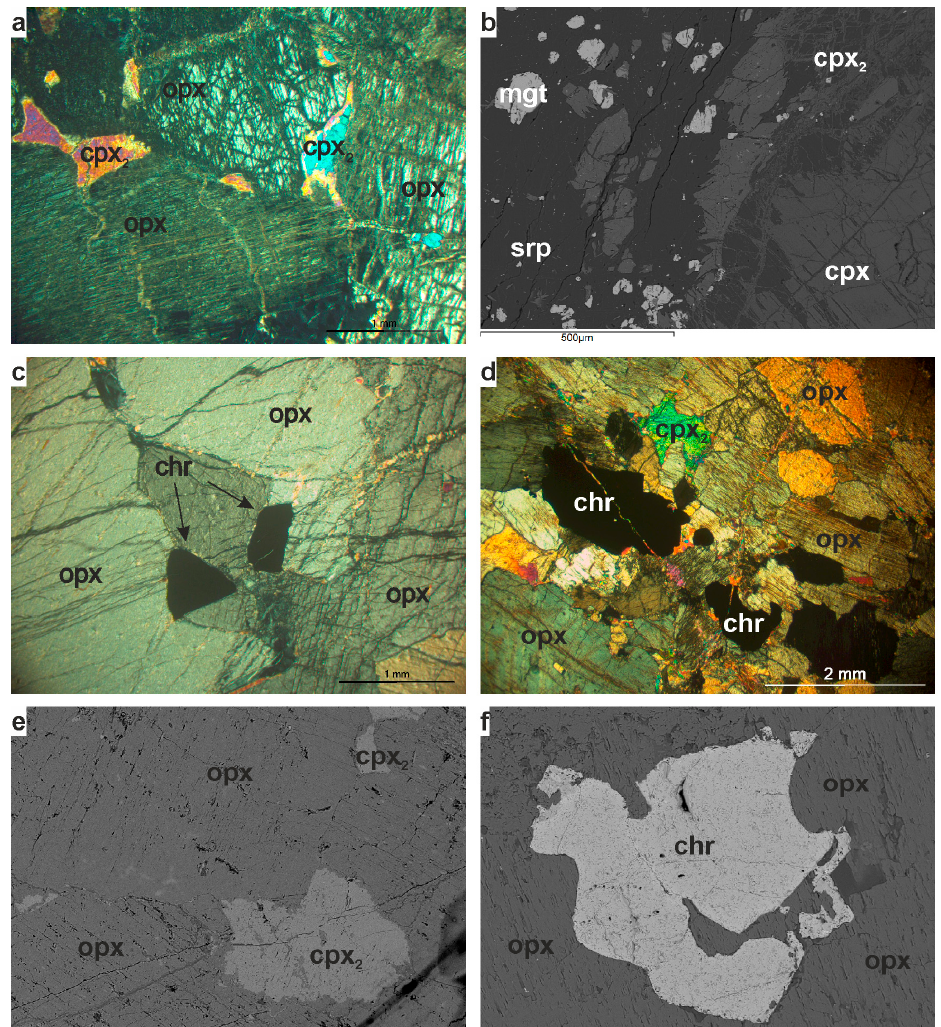
Figure 2. Textural characteristics of the pyroxenites from the Veria-Naousa ophiolite: ( a ) photomicrograph of porphyroclastic orthopyroxene (opx) with lesser clinopyroxene neoblasts (cpx 2 ) with irregular shapes in a websterite (sample BE.6; Nicols +); ( b ) backscattered electron image of subhedral clinopyroxene (cpx) surrounded by neoblastic clinopyroxene (cpx 2 ), as well as secondary serpentine (srp) and magnetite (mgt) in a websterite (sample BE.6; Nicols +); ( c ) photomicrograph of porphyroclastic orthopyroxene (opx) and subhedral grains of chromite (chr) in an Ol-orthopyroxenite (sample BE.28); ( d ) photomicrograph of porphyroclastic orthopyroxene (opx) with neoblasts of clinopyroxene (cpx 2 ) and chromite both subhedral and embayed (chr) in an Ol-orthopyroxenite (sample BE.67B, Nicols +); ( e ) backscattered electron image of clinopyroxene neoblasts (cpx 2 ) in orthopyroxene (opx) in an Ol-orthopyroxenite (sample BE.67); and ( f ) backscattered electron image of a chromite (chr) with lobate boundaries surrounded by orthopyroxene in an Ol-orthopyroxenite (sample